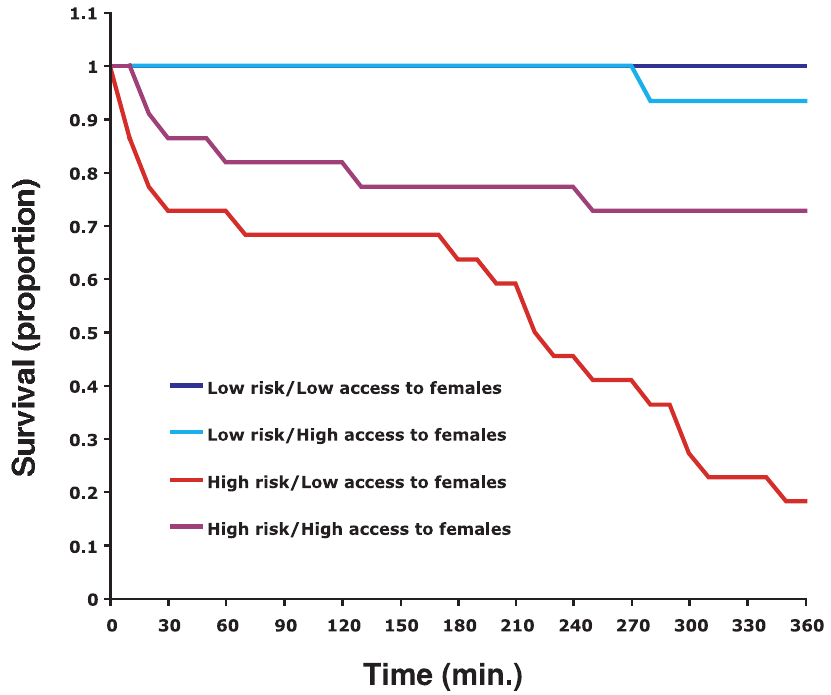
Figure 2. Survivorship curves for males for males for with low access or high prior access to females and under low- or high-risk of being attacked by female. Compared to males with high access to females, males with low access to females experienced a greater decrease in survival caused by a higher rate of sexual cannibalism when present to hungry females.